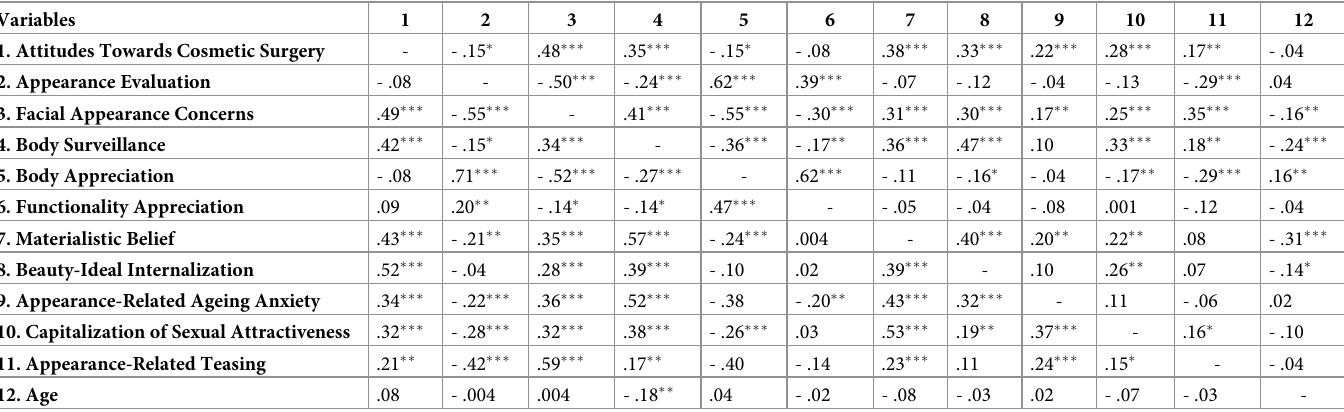
Table 3. Correlations between variables among Chinese women in China and in the Netherlands.